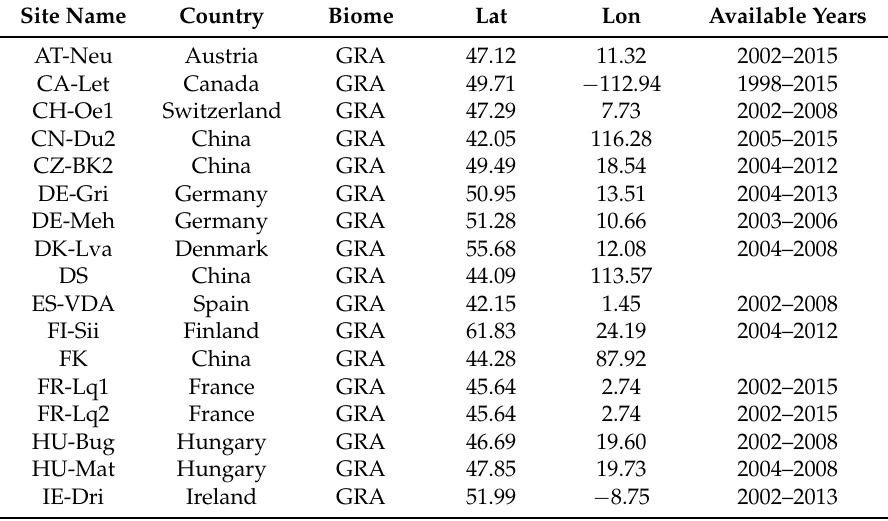
Table 1. Characteristics of validation data at the EC sites. Sites name, Latitude (Lat), longitude (Lon) and available years are shown